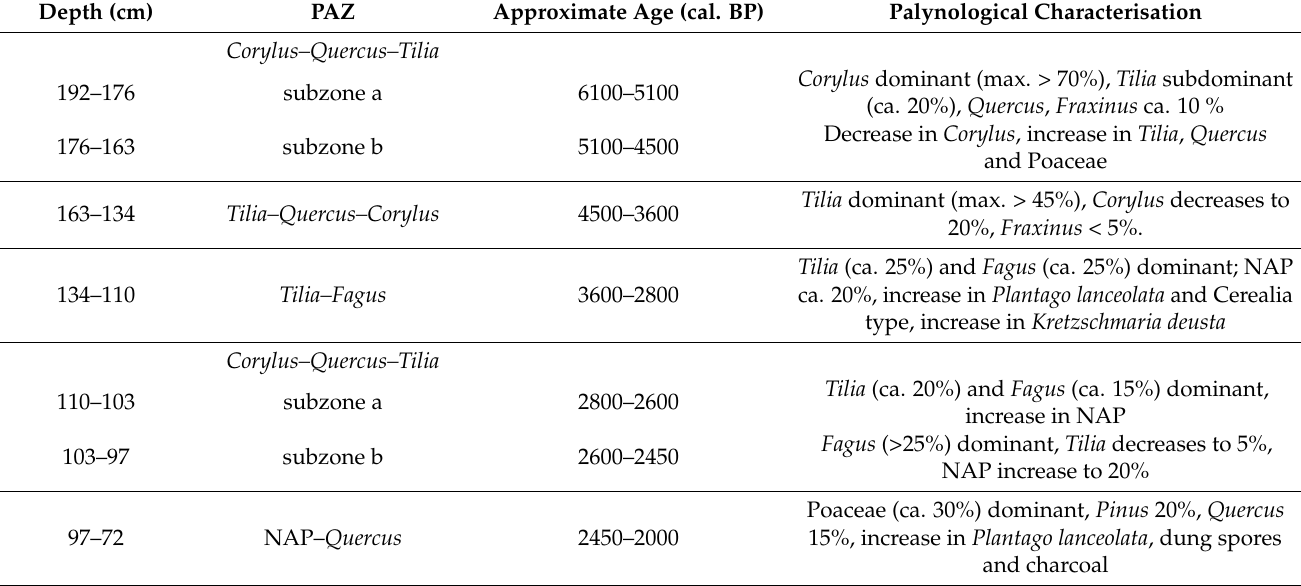
Table 3. Pollen assemblage zones (PAZ) of profile